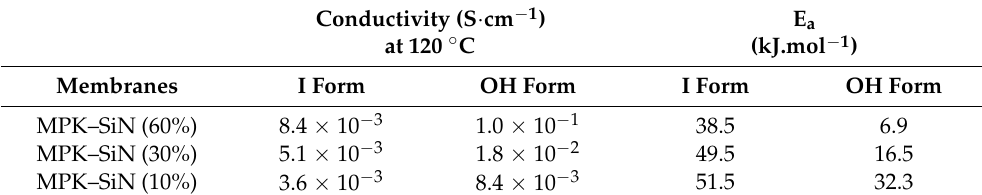
Table 1. Characteristics of the MPK–SiN membrane.